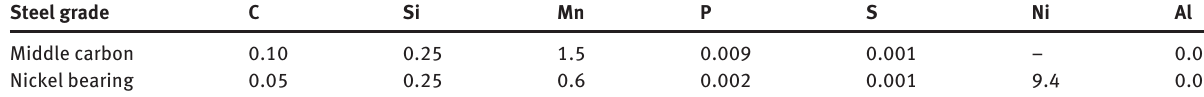
Table 2: Chemical composition of the steel grades in the plant tests. (Unit : mass%)